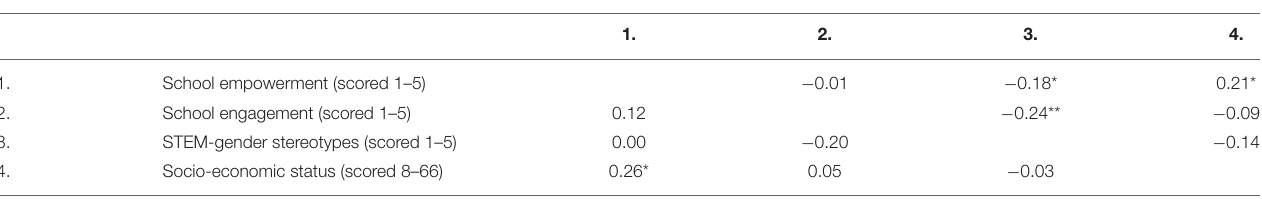
TABLE 3 | Pearson’s bivariate correlations for the Nigerian sample.